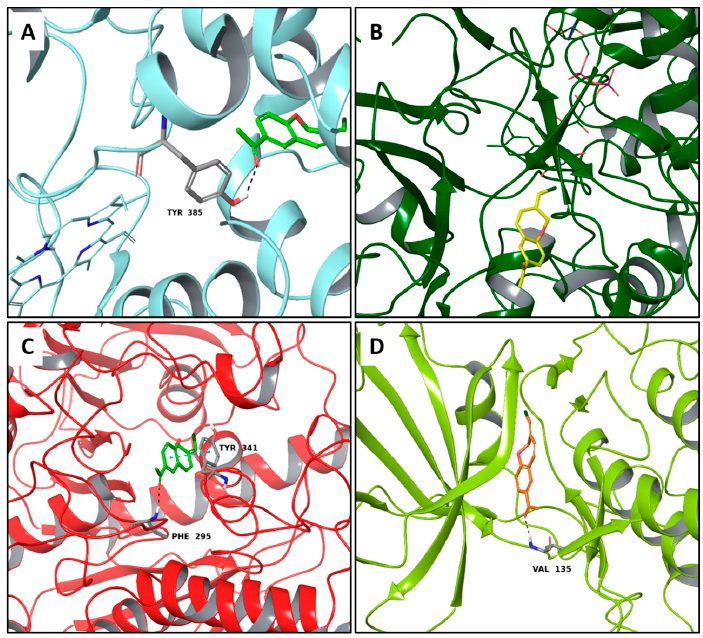
Figure 8. Molecular interactions of Pterulone and its four targets involved in the neurodegenerative diseases: ( A ) Protein target, COX-2 (PDB: 5IKR). Protein is shown as a turquoise cartoon while ligand is shown as green carbon sticks; ( B ) Protein target: MAO-B (PDB: 2V5Z). Protein is shown as a dark green cartoon while ligand is shown as yellow carbon sticks; ( C ) Protein target, AChE (PDB: 4EY7). Protein is shown as a red cartoon while ligand is shown as green carbon sticks; ( D ) Protein target, GSK3 β (PDB: 4ACC). Protein is shown as a light green cartoon while ligand is shown as orange carbon sticks. H-bonds and π - π interactions are shown as dashed black and cyan lines, respectively. Aminoacidic residues involved in the interactions are shown as gray sticks. Table 4. Fungal components with best theoretical affinities (G-score) against multiple targets involved in the metabolic diseases.